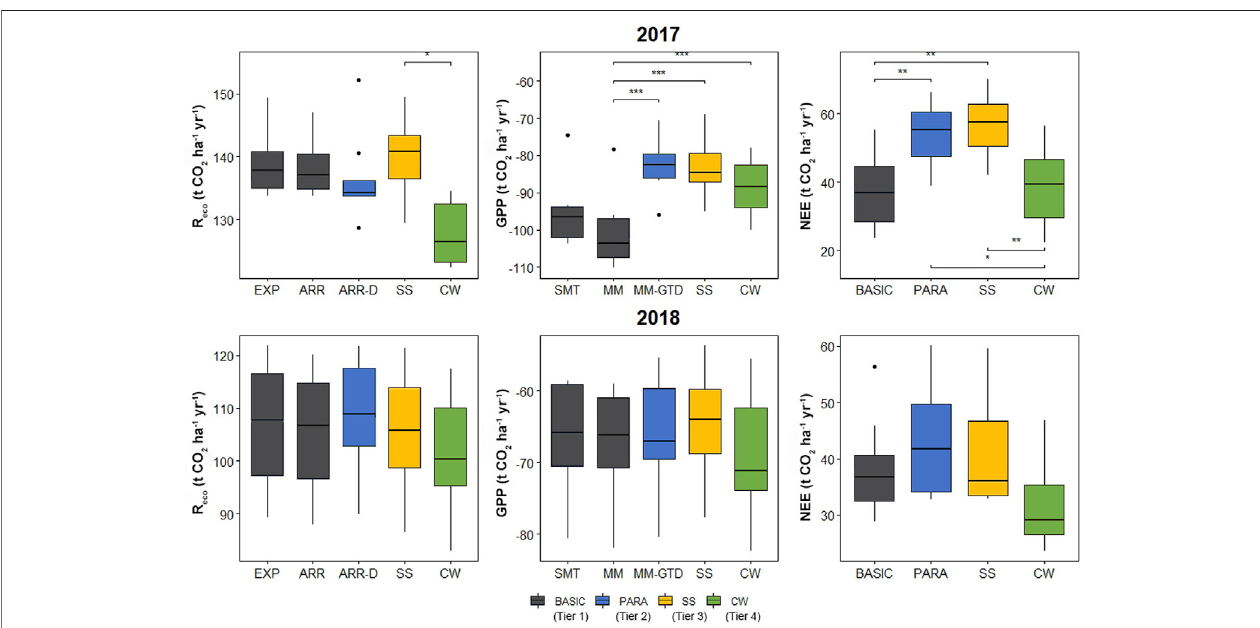
FIGURE 3 | Gap- fi lled annual R eco, GPP and NEE budgets from different model selections and combinations in both years. The box indicates the median and the upper/lower quartiles. The whiskers represent the maximum and minimum values. Filled points are the outliers. The asterisks between boxes indicate signi fi cant differences between models based on linear mixed-effects (LME) models (* p < 0.05; ** p < 0.01; *** p < 0.001).